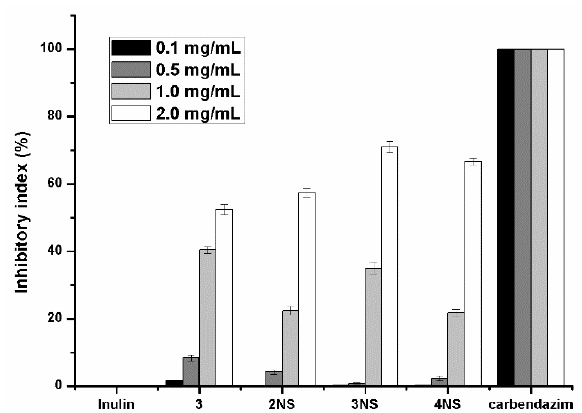
Figure 6. Antifungal activity of inulin and the inulin derivatives against P. asparagi.